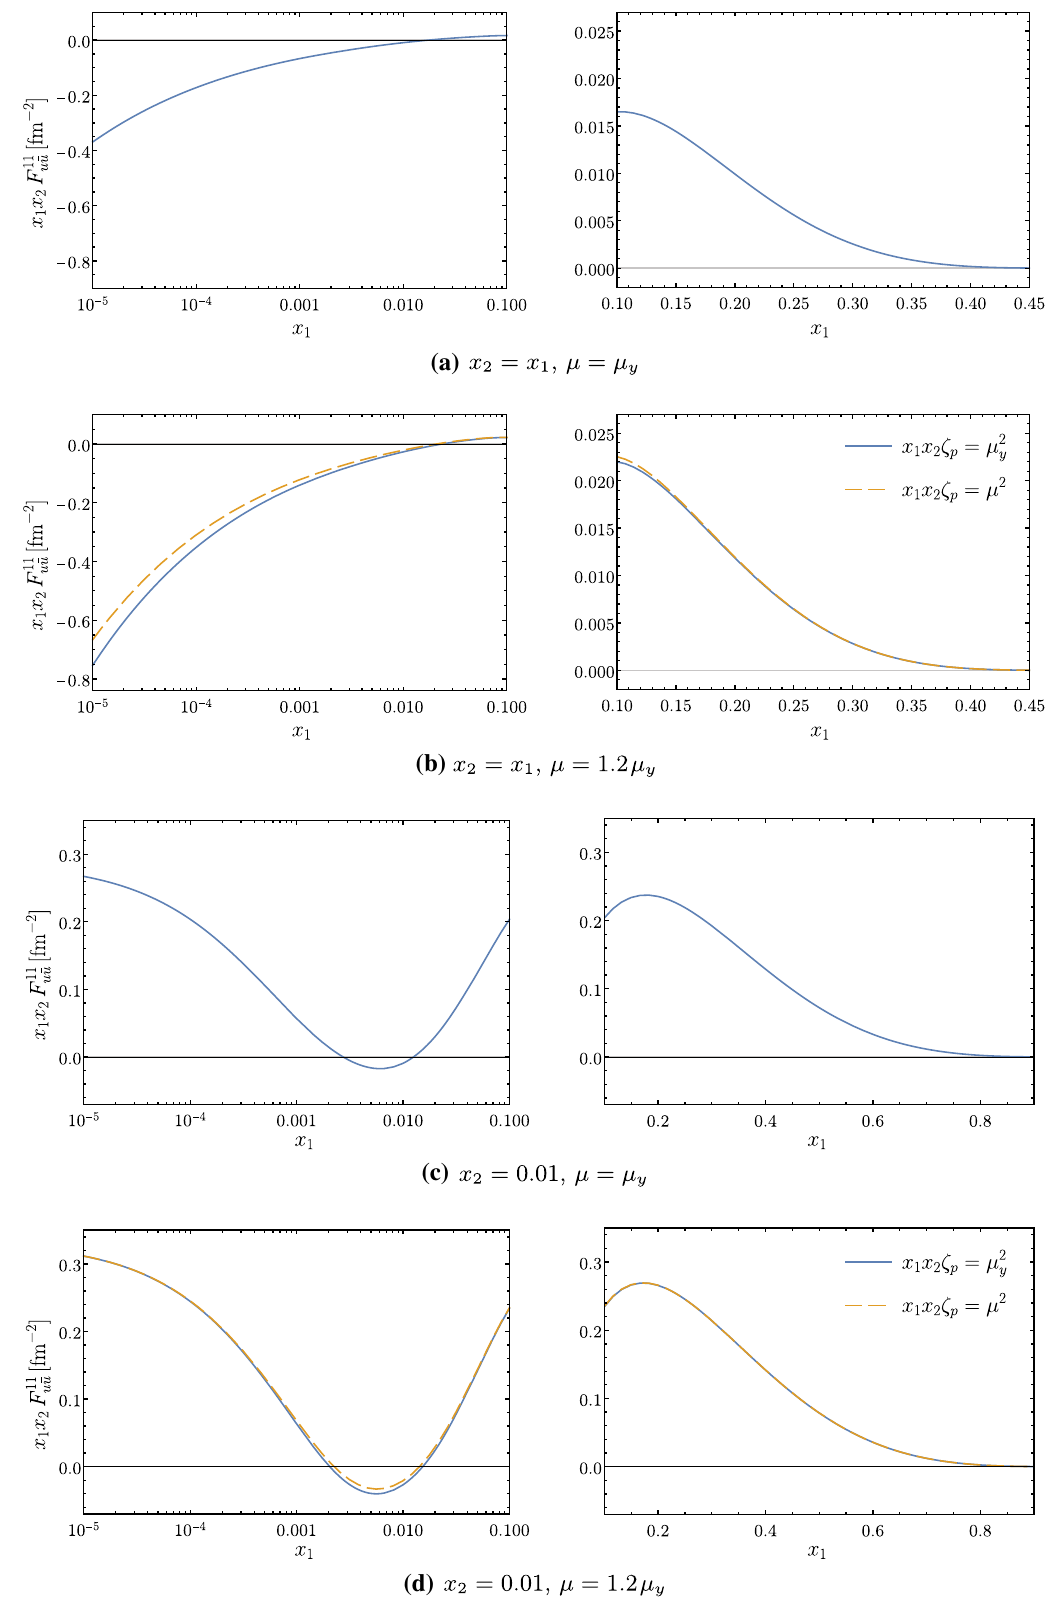
Fig. 11 The distribution F 11 computed with the two-loop splitting formula for μ y = 10GeV and two choices of u ¯ u